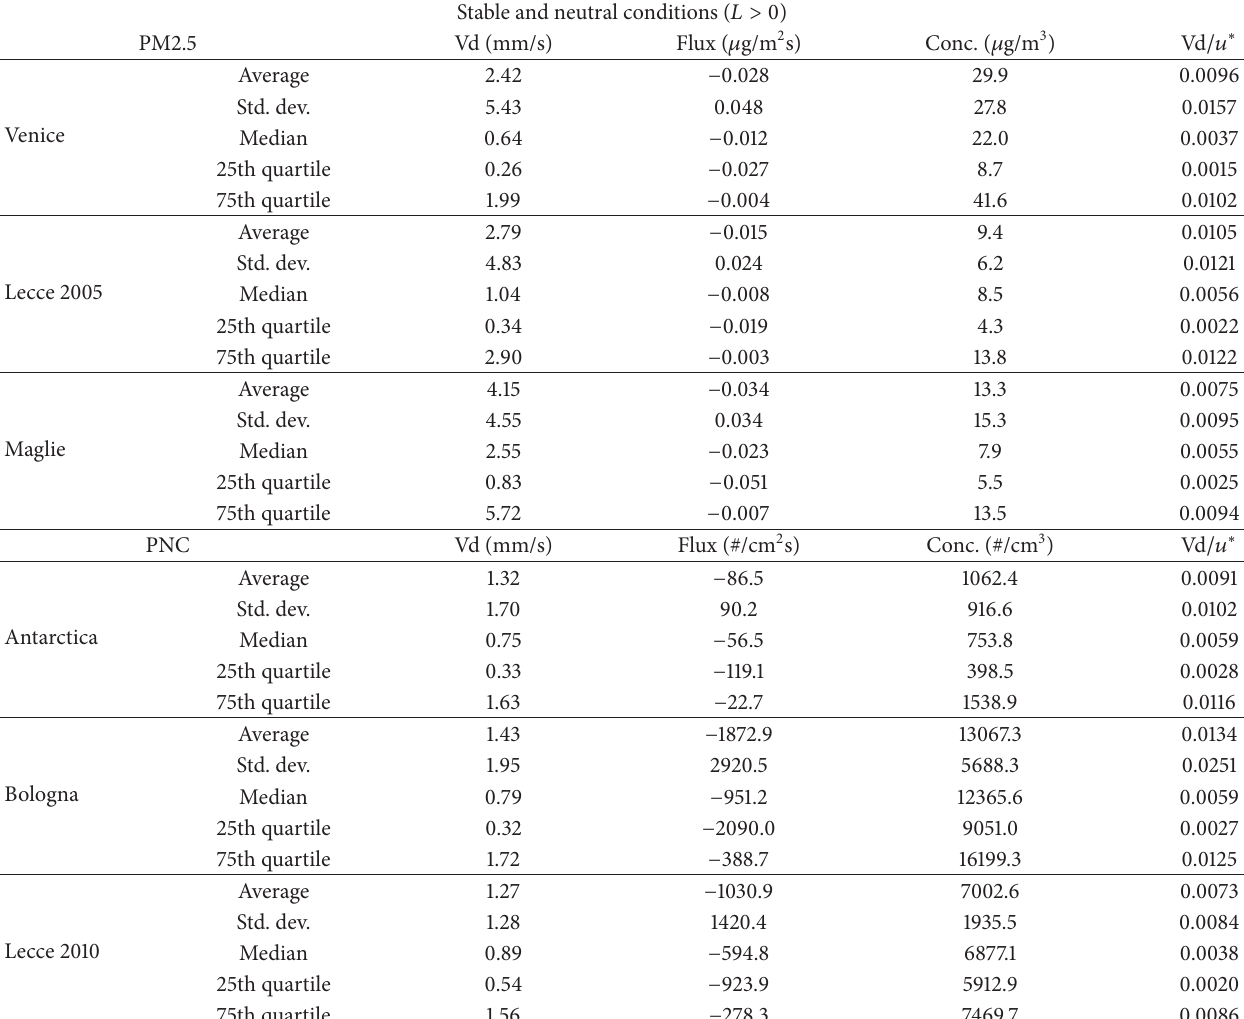
Table 5: Average (with standard deviation) and median (with 25th and 75th quartiles) values are reported for deposition velocities, fluxes, concentrations, and normalized deposition velocities for each site, separating PM2.5 from particle number data. In this table data is selected for stable atmospheric stability cases 𝐿 > 0 (including quasi-neutral cases).